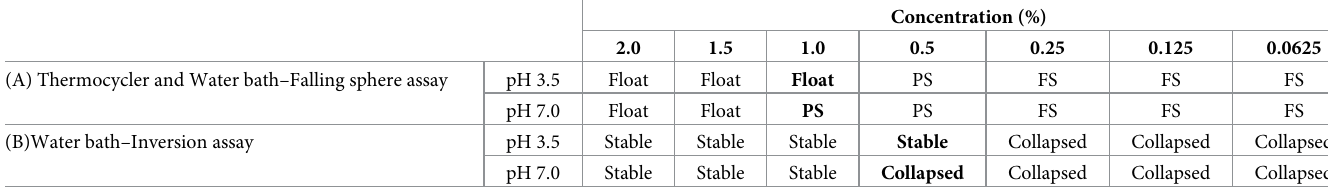
Table 4. Gelation results of non-supplemented low acyl gellan at pH 3.5 and